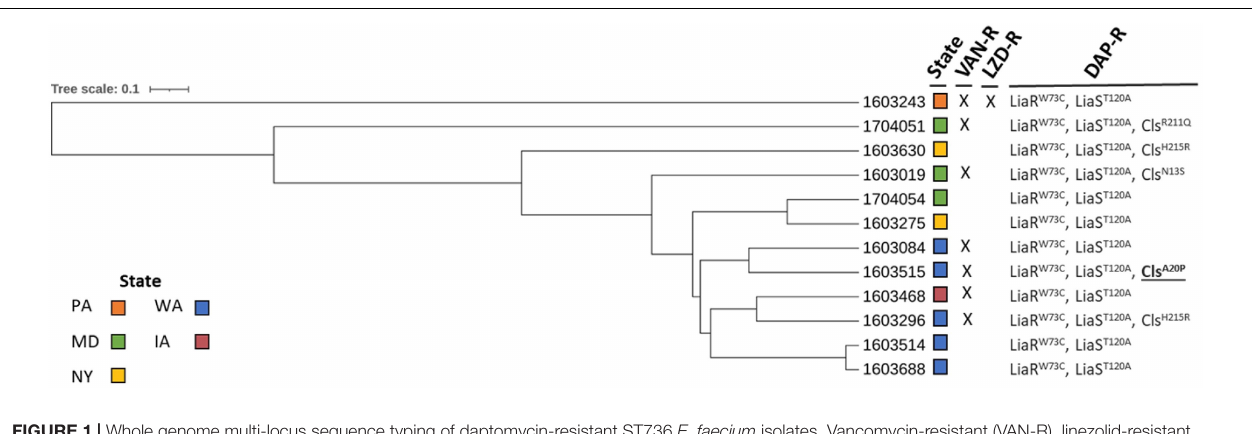
FIGURE 1 | Whole genome multi-locus sequence typing of daptomycin-resistant ST736 E. faecium isolates. Vancomycin-resistant (VAN-R), linezolid-resistant (LZD-R), and daptomycin-resistant (DAP-R) profiles are indicated (X: resistant). Amino acid mutations in LiaR, LiaS, and Cls are designated (Cls mutation